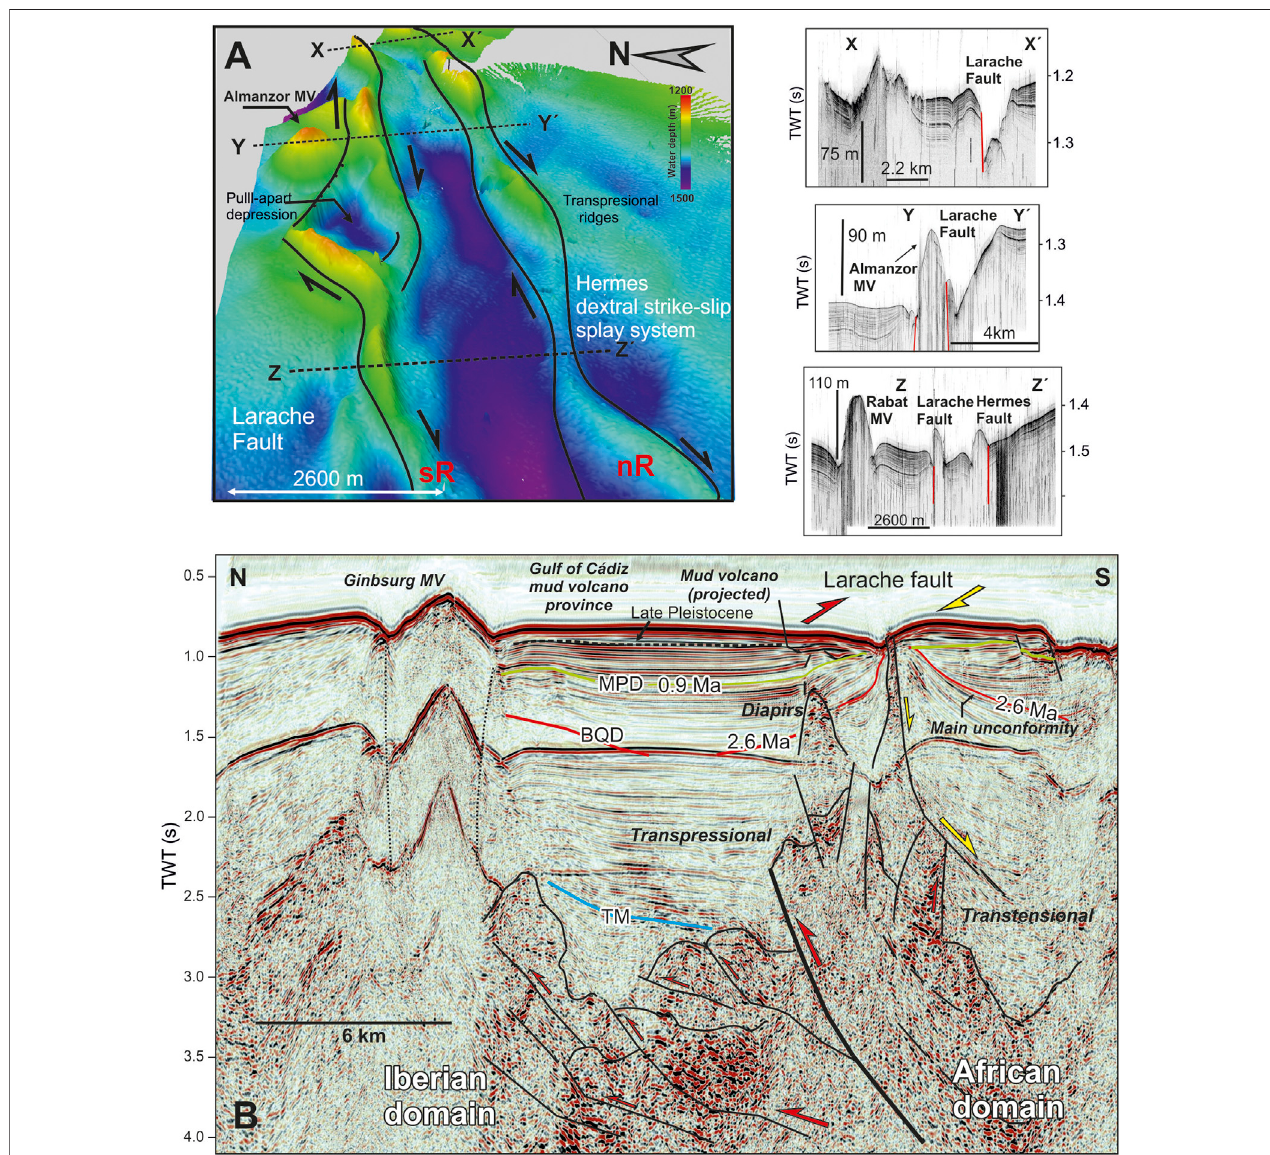
FIGURE 6 | (A) Upper left: 3 days image of the swath bathymetry showing sea fl oor expression of the ESE strike-slip Larache fault: nR and sR (cid:2) north and south ridges; Upper right: Ultra high-resolution pro fi les across the fault. See location in Figure 2 . (B) Multichannel seismic section (Moundforce 02) showing the subsea fl oor expression of the Larache fault composed by a fl ower-like structure dividing two main domains: Iberian and Africa. Unconformities are taken from Toyos et al. (2016).